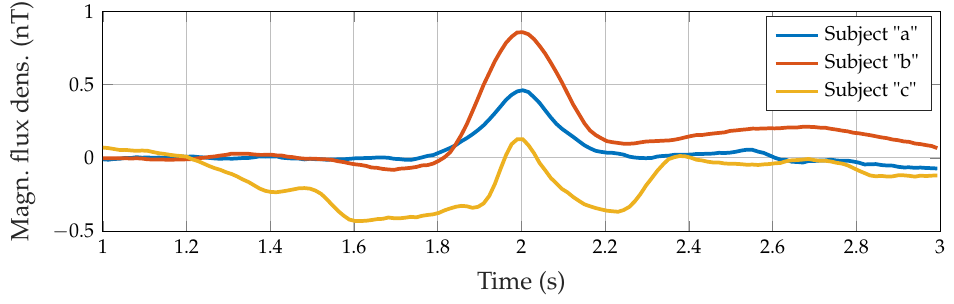
Figure 6. Prototype swallowing signal for each subject. From the second experiment with the dual actuator setup (Subject “b”, six addi- tional trials of water intake), we evaluated the consistency between data provided by both actuators (Figure 7). The swallowing pattern can be further validated: for all nine swallowing trials for Actuator A, a pulse width of 33.68 ms with a standard deviation of 1.00 ms occurred. The mean amplitude was 0.79 0.28 nT. For the assessed subject, ± the amplitude exhibited a clear difference between swallowing tasks: 0.35 0.07 nT for ± saliva and 1.49 0.23 nT for yogurt. These results are also visible in Figure 5. Otherwise, ± consistent measures were found in data from Actuator B, despite the sixth trial which behaves as an